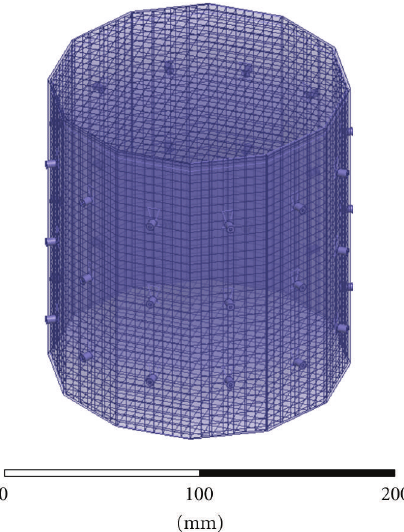
Figure 6: HFSS CAD model of the imaging cavity with mesh of unassigned sheets to constrain the adapting meshing of HFSS for field interpolation. Sheets are spaced every 5 mm in each direction.